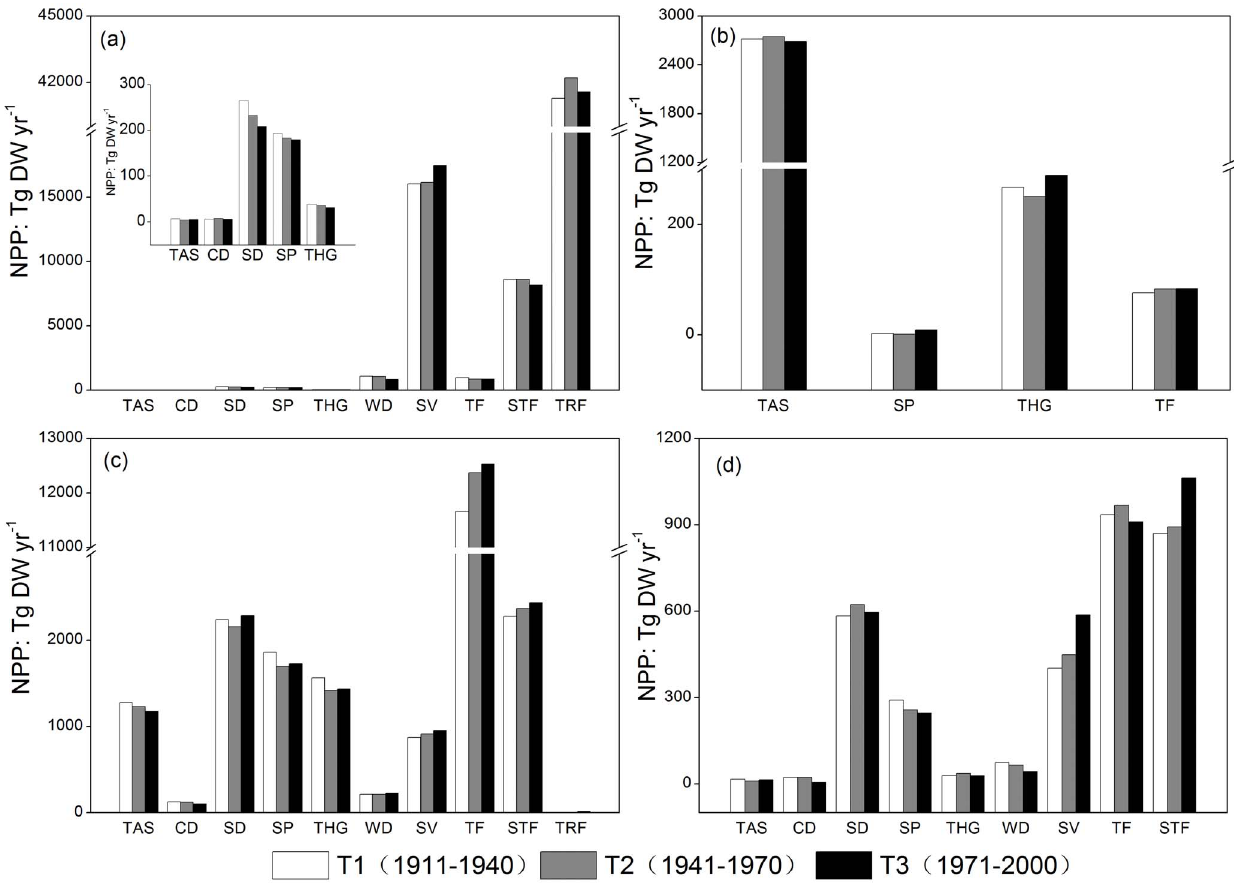
Figure 5. Variations of terrestrial ecosystems NPP in climatic zones in the period 1911–2000. (a): Tropical zone, (b): North frigid zone, (c): North temperate zone, (d): South temperate zone. South frigid zone was not involved in this research. TAS: tundra & alpine steppe; CD: Cold desert; SD: Semi-desert; SP: Steppe; THG: Temperate humid grassland; WD: warm desert; SV: savanna; TF: Tempearte forest; STF: Subtropical forest; TRF: Tropical